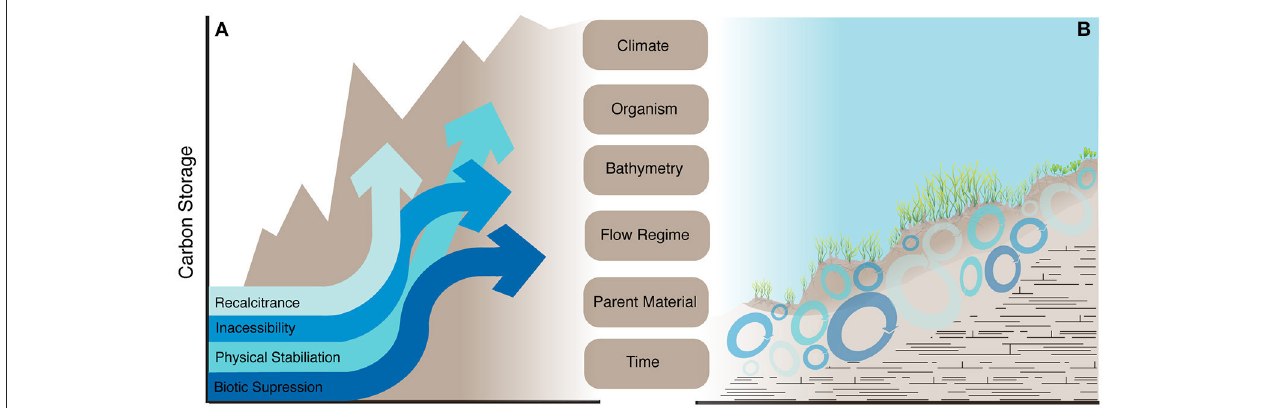
FIGURE 1 | Conceptual diagram of (A) the four OC stabilization mechanisms operating over time (x-axis) that lead to an increase of OC storage, represented by the increasing brown shaded area behind the arrows. Each mechanism can work alone or in tandem, and the strength of each can potentially change over time, which is illustrated by the changes in slope and direction of the arrow heads. The relative importance and strength of the four mechanisms are modulated by the six state-factors ( Jenny, 1941; Demas and Rabenhorst, 2001). To illustrate (B) is a hypothetical seagrass meadow with OC cycling over a spectrum of timescales (illustrated by different sized circles) with the four stabilization mechanisms (represented by the various blue shades) dominating in different locations. The exact location and prevalence of each mechanism(s), with their inherent effects on OC residence times, will ultimately depend on the unique combination of state factors, which set the boundary conditions for the process of OC